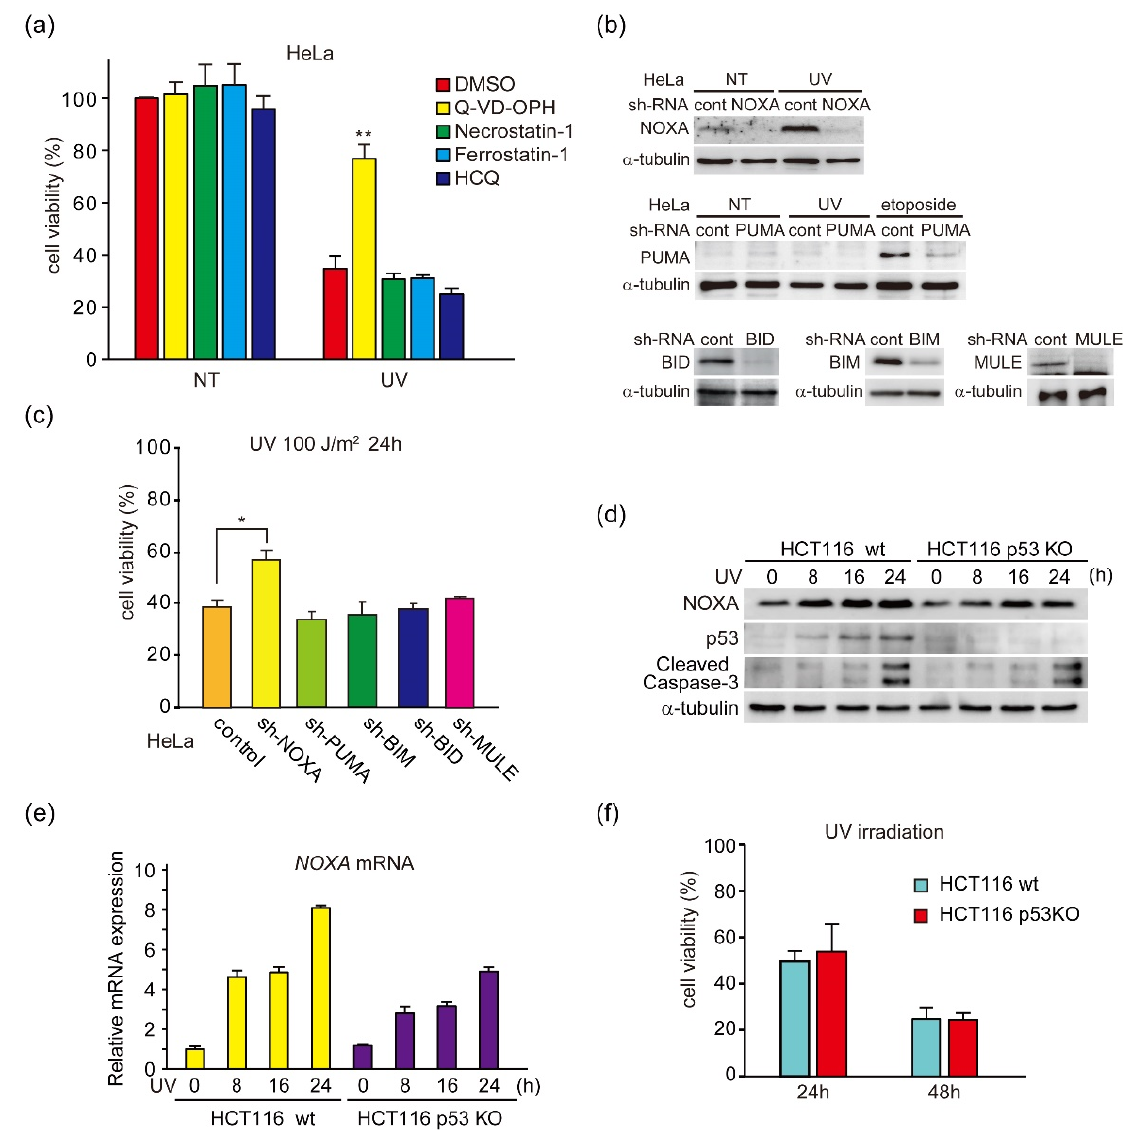
Figure 1. NOXA is a regulator of UV-induced apoptosis. ( a ) HeLa cells were irradiated with UV light (100 J/m 2 ) in the absence (DMSO) or presence of programmed cell death inhibitor; apoptosis (Q-VD-OPH; 20 µ M), necroptosis (Necrostatin-1; 30 μM), ferroptosis (Ferrostatin-1; 2 μM) and autophagy (HCQ; 20 µ M). Error bars indicate S.E.M. ( n = 3). (** p < 0.01, Welch’s t -test; n = 3). ( b ) HeLa cells stably expressing shRNA-targeting NOXA (sh-NOXA), PUMA (sh-PUMA), or sh-control were irradiated with UV light (100 J/m 2 ) or stimulated by etoposide (100 µ M). After a 24 h treatment, 20 µ g of total cell lysates was subjected to immunoblot analysis with the indicated antibodies (upper panel). HeLa cells stably expressing shRNA-targeting BIM (sh-BIM), BID (sh-BID), MULE (sh-MULE), or sh-control were analyzed by immunoblot analysis (lower panel). Quantitative analysis of immunoblot results is shown Supplementary Figure S1a. ( c ) HeLa cells were irradiated with UV light (100 J/m 2 ). After a 24 h treatment, cell viability was determined using CCK-8 analysis. Error bars indicate S.E.M. ( n = 3). (* p < 0.05, Welch’s t -test; n = 3). ( d – f ) Cells were irradiated with UV light (100 J/m 2 ). After the indicated treatment time, cells were analyzed by immunoblot analysis using indicated antibodies ( d ). Anti-cleaved caspase-3 antibody recognizes the large subunit of active caspase 3, immature p19 and fully mature p17 [34], but not the small subunit (p12) and uncleaved procaspase-3. In the following experiments, both p19 and p17 were often detected, but depending on the experimental condition, only active p17 was detected. Quantitative analysis of immunoblot results is shown in Supplementary Figure S1b. NOXA mRNA levels were determined by qPCR ( e ). Cell viability was determined using CCK-8 analysis. Error bars indicate S.E.M., ( n = 3) ( f ). 3.2. UV Light Induces NOXA Expression through the ERK Pathway Apoptosis is regulated by many intracellular signaling pathways, including the mi- togen-activated protein kinase (MAPK) pathway [35]. UV signal has been shown to be